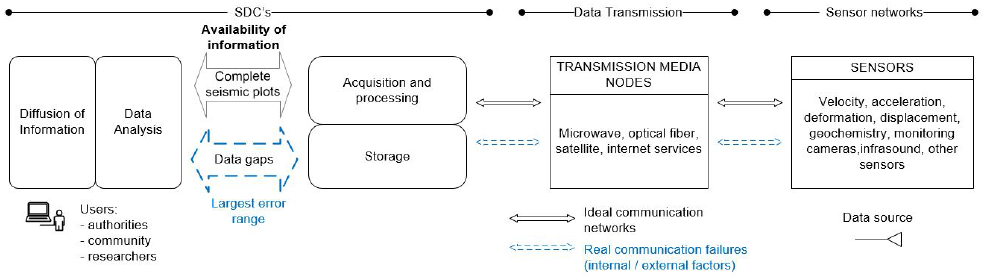
Figure 1. Seismic-volcanic monitoring systems. A general